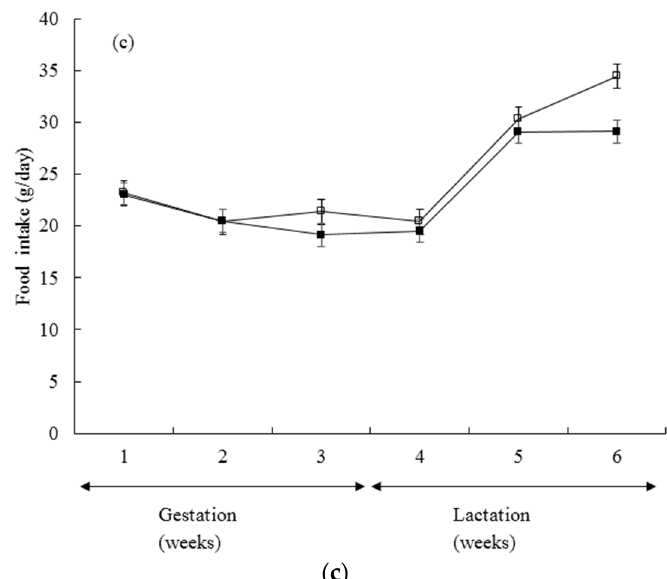
Figure 2. Values are means with standard errors represented by vertical bars. ( a ) Body weight changes during pregnancy and lactation in rats fed control (C, n = 6) or low quality protein (WG, n = 7) diets; ( b ) Average daily energy intakes during each week of pregnancy and lactation period in rats fed control (C, n = 6) or low quality protein (WG, n = 7) diets; ( c ) Average daily food intakes during each week of pregnancy and lactation periods in rats fed control (C, n = 6) or low quality protein (WG, n = 7) diets. Table 1. Birth weight, offspring’s body weight during lactation and estimation of milk yield. Males Females C WG C WG Birth weight (g) 5.96 ± 0.14 C